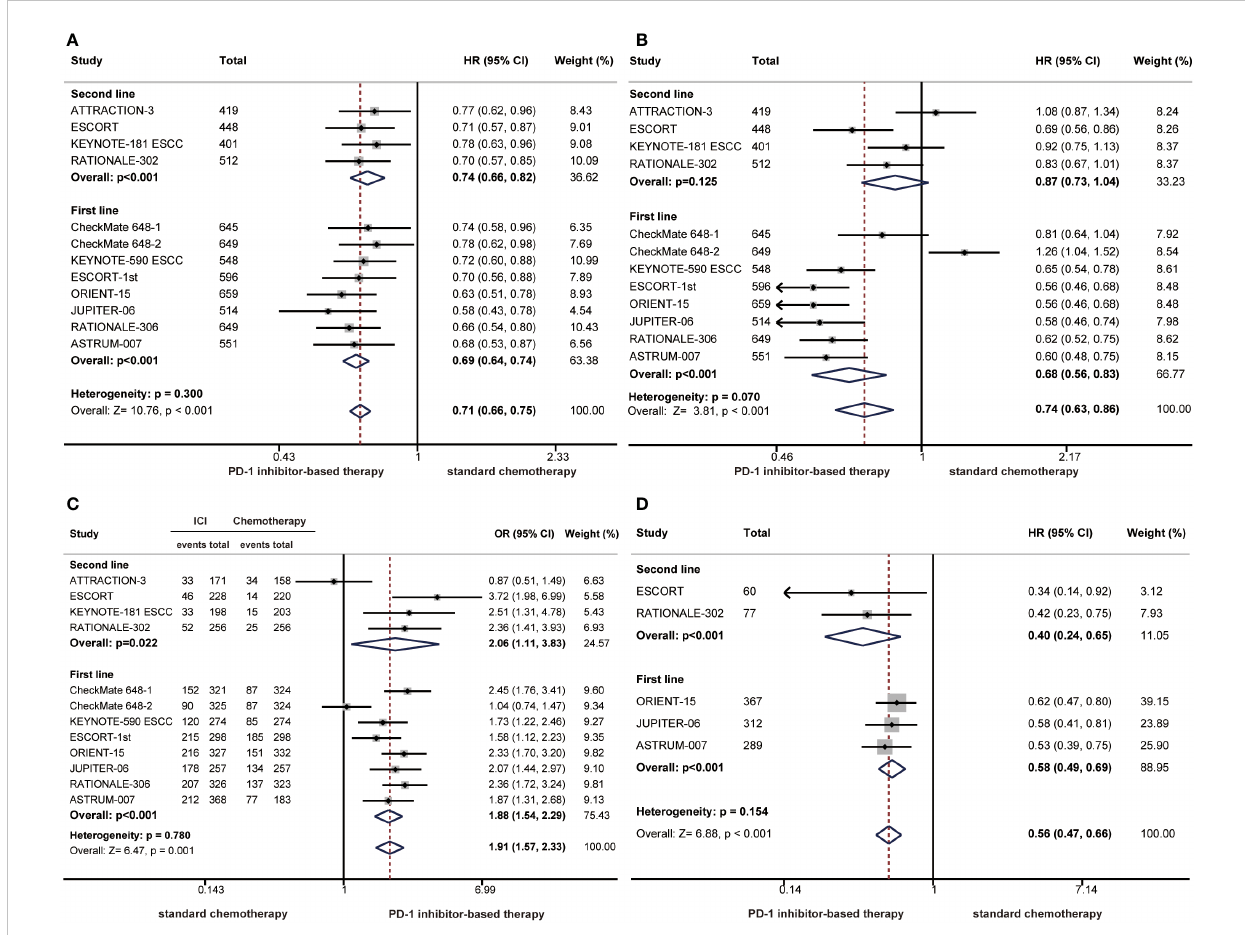
FIGURE 2 Forest plots of subgroup analysis by treatment lines comparing overall survival (A) , progression-free survival (B) , objective response rate (C) , and duration of response (D) in patients who received PD-1 inhibitor-based therapy versus chemotherapy. (HR, hazard ratio; OR, odds ratio; CI, con fi dence interval; PD-1, programmed cell death